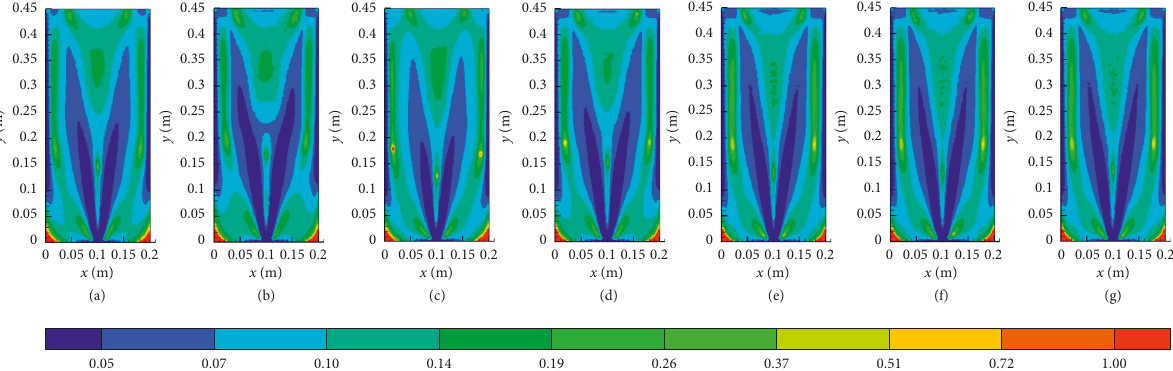
Figure 8: Instantaneous dynamic viscosity distribution of liquid phase. (a) Case 8, (b) Case 9, (c) Case 10, (d) Case 11, (e) Case 12, (f) Case 13, and (g) Case 14.